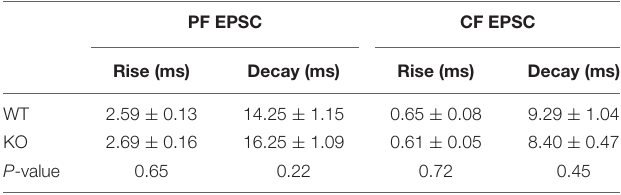
TABLE 1 | PF and CF EPSC kinetics were normal in TRH-KO mouse